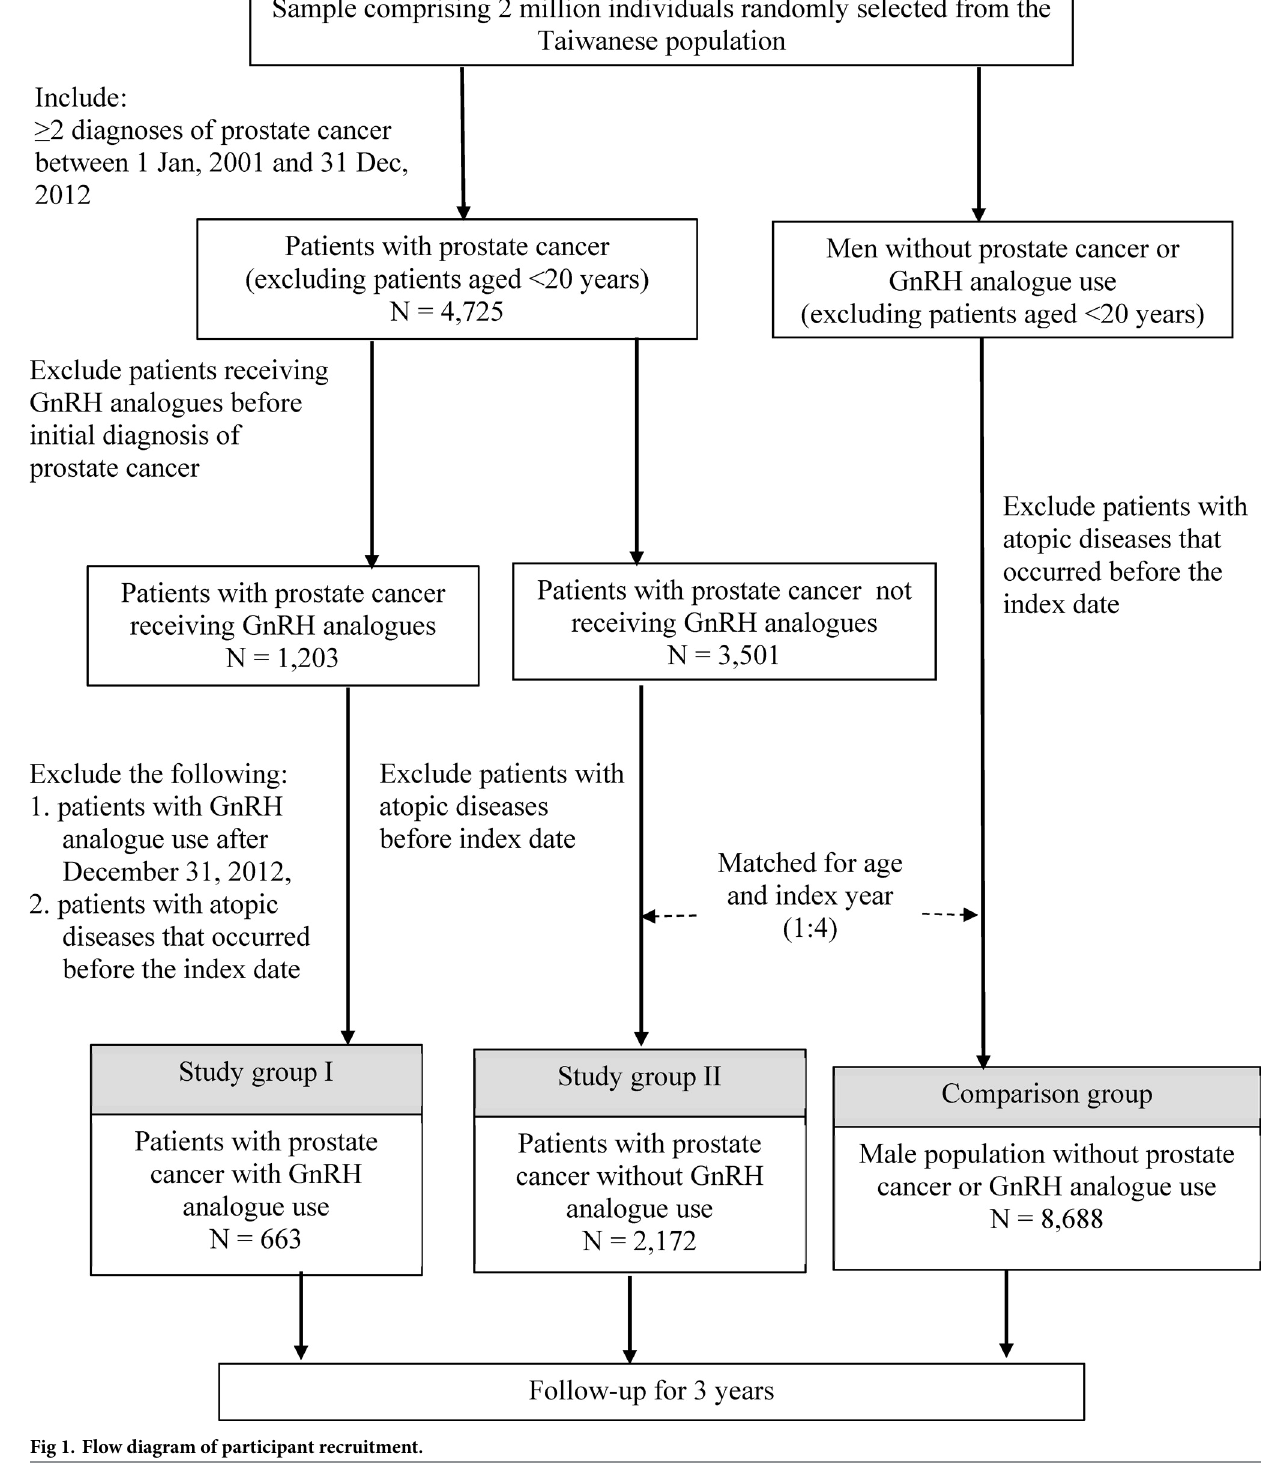
Fig 1. Flow diagram of participant recruitment.